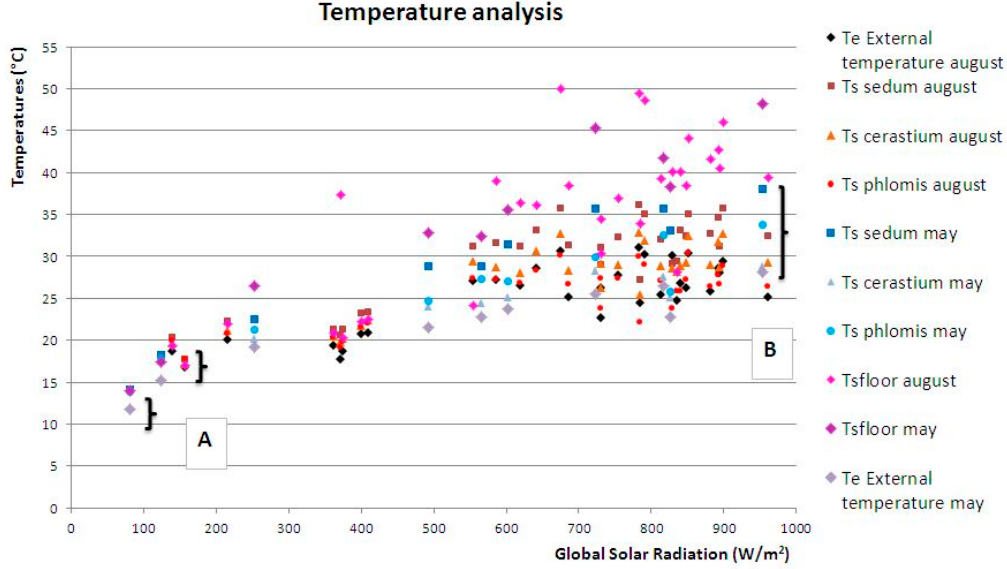
Figure 6. Analysis of the surface temperatures of the plant species (T s ) as a function of the global solar radiation and the external temperature.